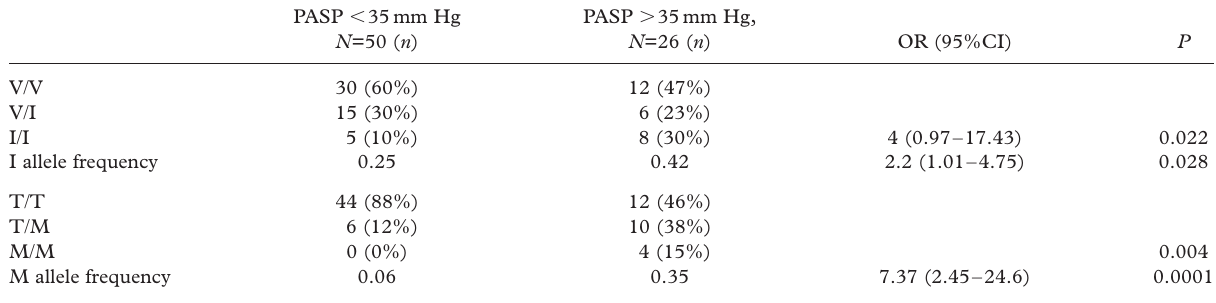
Table III. 3. Odds ratios for genotypes were calculated with V/I þ V/V vs I/I and T/M þ T/T vs